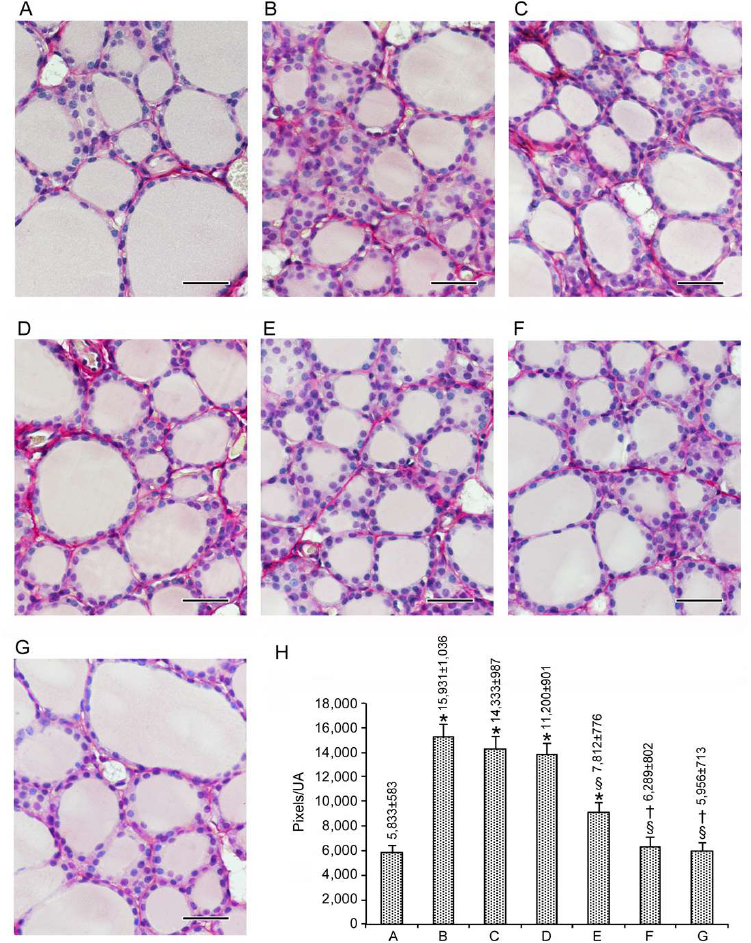
Figure 2. Structural organization of the thyroid stroma based on staining with Sirius Red (scale bar: 25 μm). Mice groups are as in Figure 1. ( A ): Control mice have a normal architecture of interstitial collagen, with well-stained fibrillary elements, as indicated by bar A in H. ( B ): In CdCl 2 -treated mice, an increased amount of perifollicular connective tissue is present around the follicles, as indicated by bar B in H. ( C - D) : In mice challenged with CdCl 2 and 0.2 mg/kg Se or CdCl 2 and 0.4 mg/kg Se, stained areas are similar to mice challenged with CdCl 2 , as shown by bars C and D in H. ( E ): CdCl 2 plus MI-treated mice have stained areas with a statistically significant decrease in the pink/red colored collagen fibers, as evident in H, bar E. ( F-G ): In mice treated with CdCl 2 plus MI and 0.2 mg/kg Se or CdCl 2 plus MI and 0.4 mg/kg Se, a significant reduction in the stained areas can be seen, as also demonstrated by bars F and G in H. ( H ): Mean ± standard error values of pixel numbers of Sirius Red (SR)-stained areas/unit areas (UA) in the different groups of challenged mice.* p < 0.05 versus control; § p < 0.05 versus CdCl 2 plus vehicle and CdCl 2 plus 0.2 or 0.4 mg/kg Se; † p < 0.05 versus CdCl 2 plus MI.